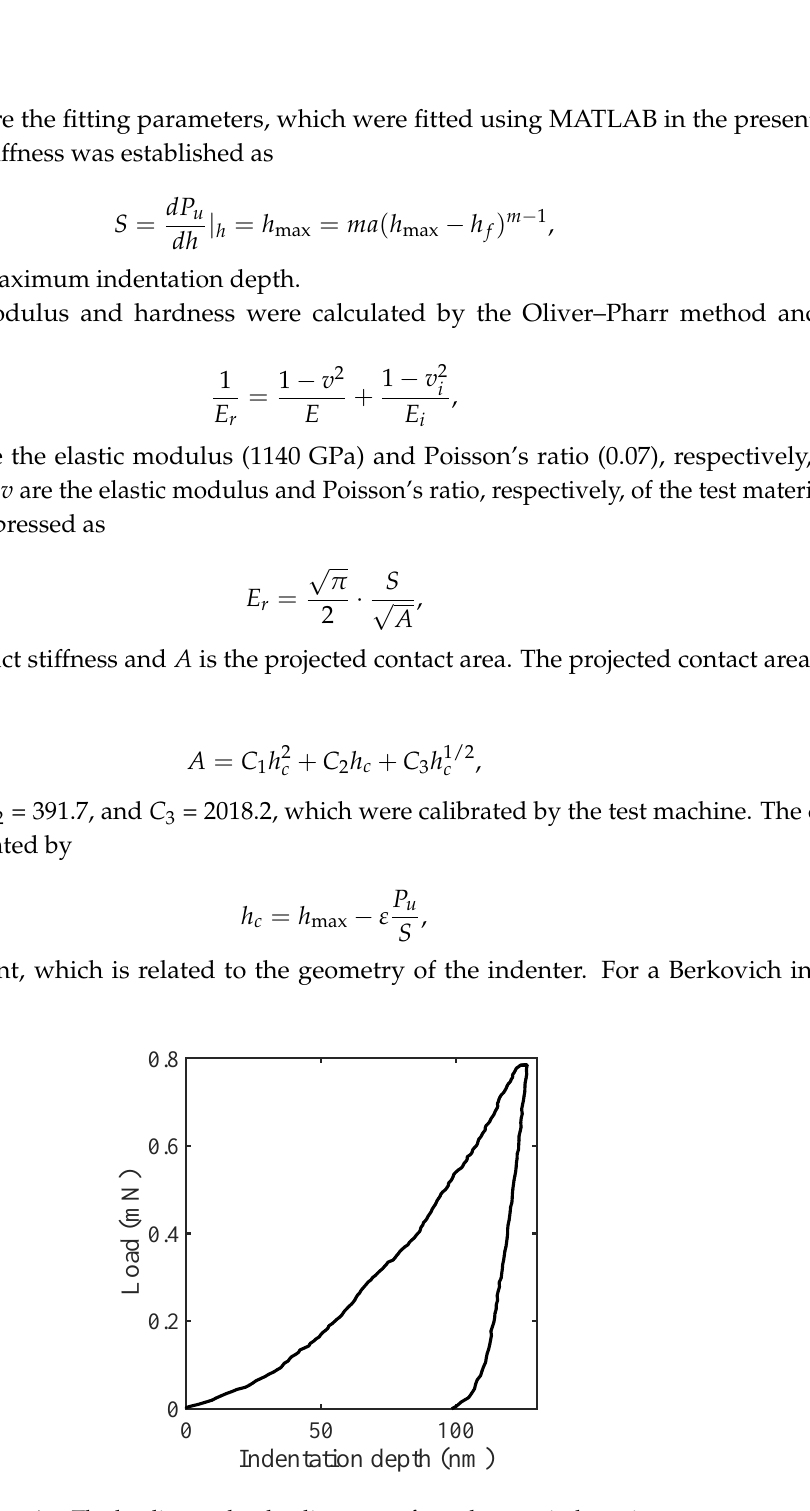
Figure A1. The loading and unloading curve from the nanoindentation